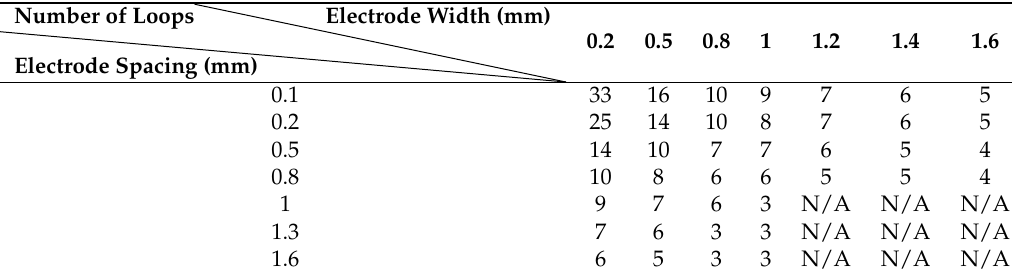
Table 2. Parameters of FEF (fringing electric field) sensors whose area are 2 cm × 2 cm and patterns are interdigital in Figures 7 and 8.